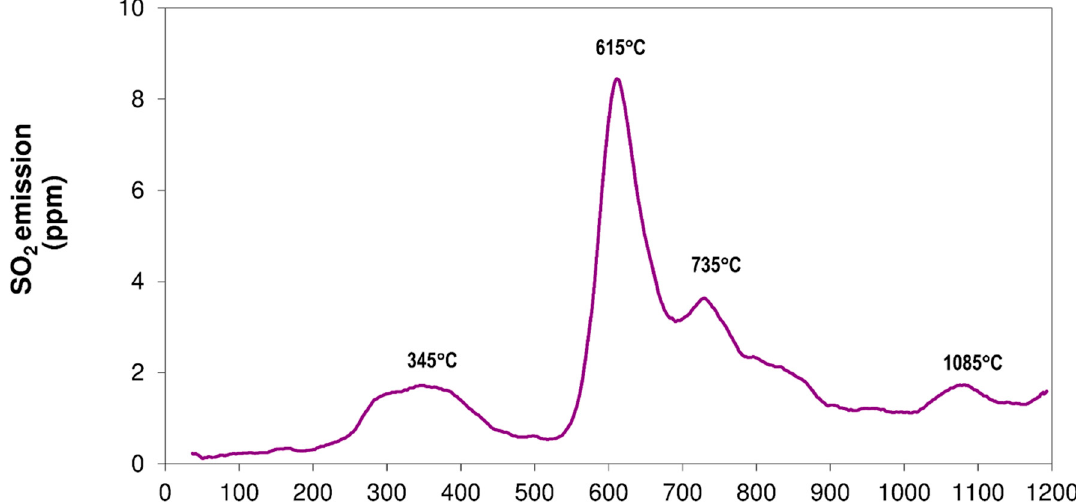
Figure 7. SO 2 curve emission for sample BCS-CRM 348 Ball clay.